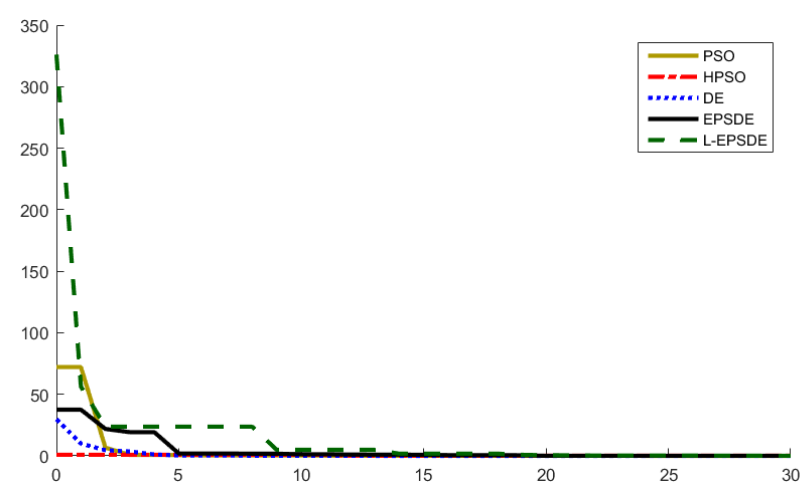
Figure 9. Trajectory of the coupler point of Case 1.